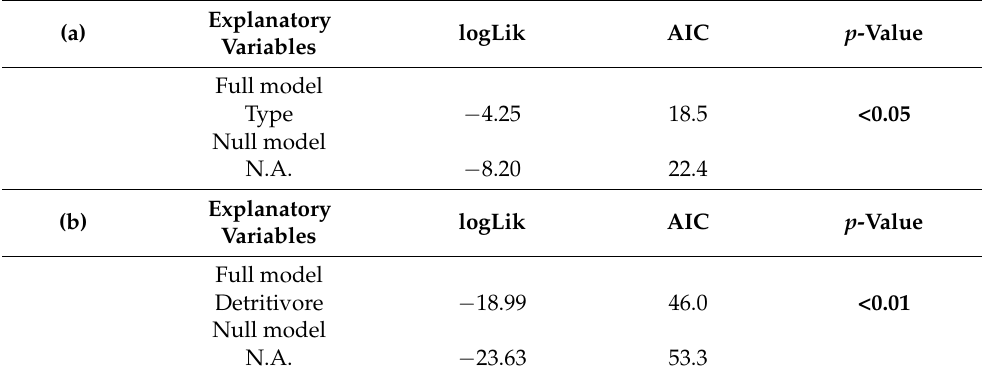
hyporheic zone, and treatment hyporheic zone) on log 10 -transformed leaf litter decomposition rate ( k